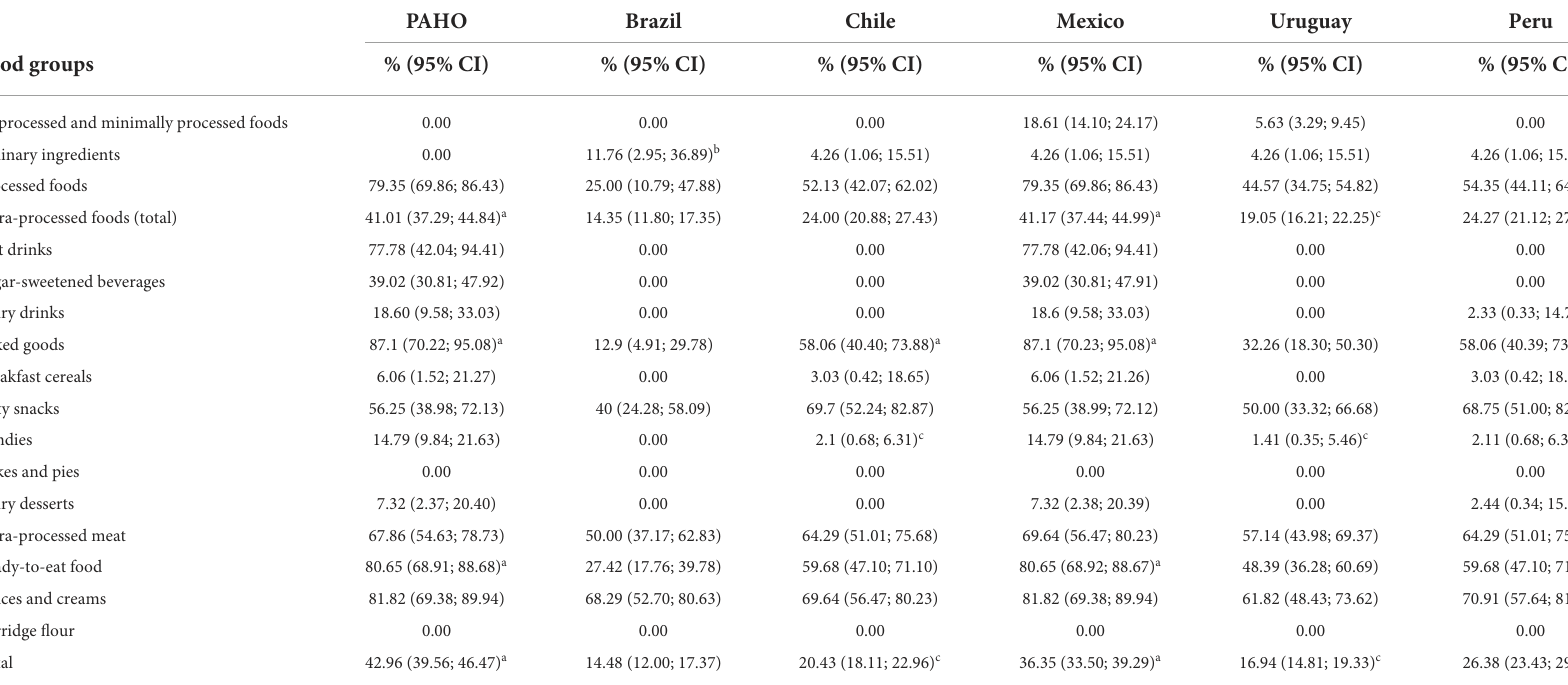
TABLE 4 Proportion (%) of foods and beverages with child-directed marketing and a high content of sodium according to different nutrient profile models (NPM), overall, and by food category (Brazil, 2017). PAHO Brazil